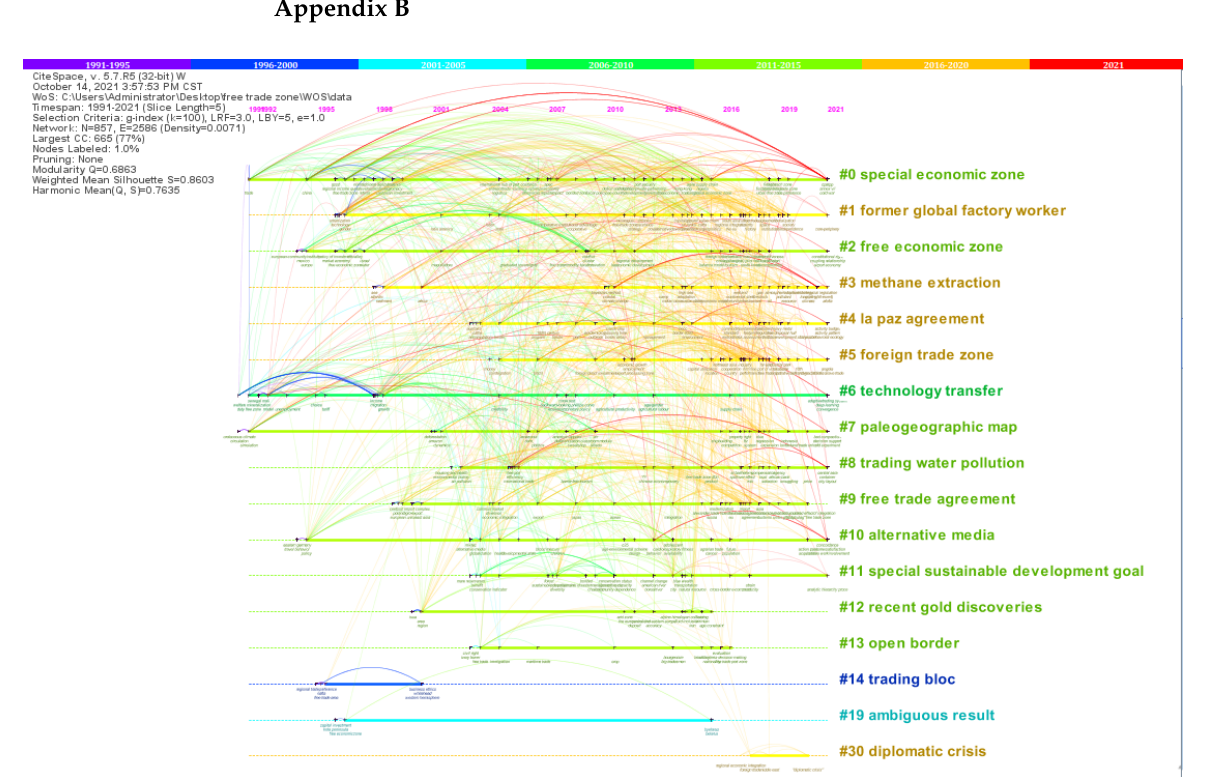
Figure A1. The timeline view of the keyword knowledge map. Note: Figure A1 is an auxiliary map to Figure 10 and Table 5 to indicate the keyword clustering through the time variation.